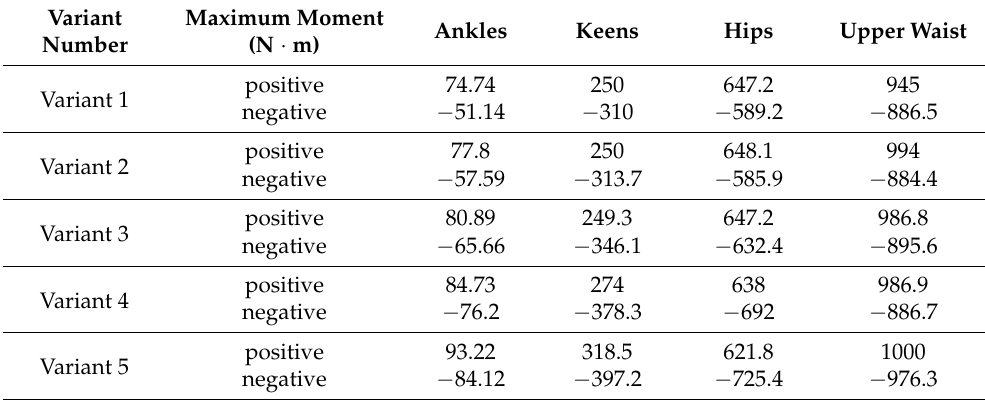
Figure 8. Joint moments under different trunk oscillations. Table 2. Maximum positive and negative moments of different joints under different trunk oscilla- tions.